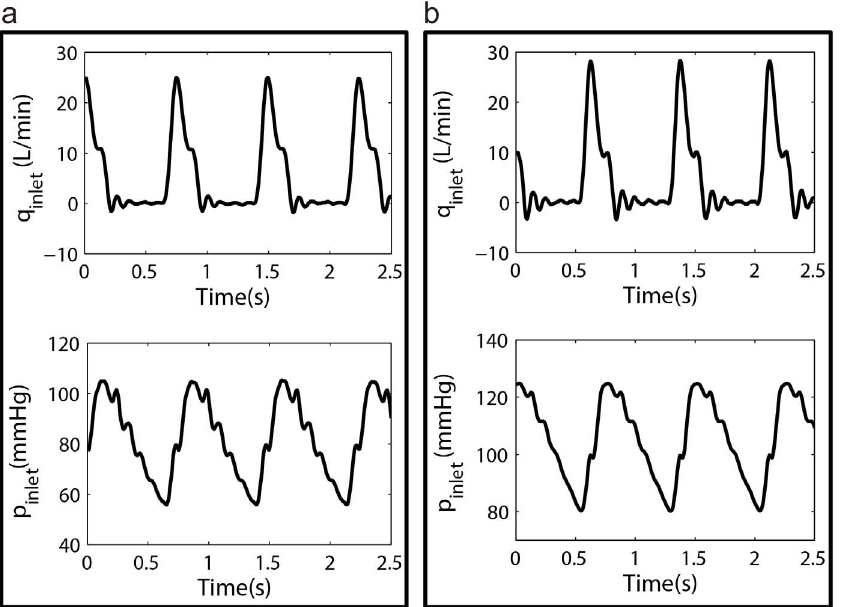
Figure 4. Samples of hemodynamic waveforms. a) A sample of an aortic input flow wave (top) and a sample of the aortic input pressure wave (bottom) at HR=72 bpm and CO=5 L/min for setup 2 b). A sample of an aortic input flow wave (top) and a sample of the aortic input pressure wave (bottom) at HR=80 bpm and CO=5 L/min for setup 1.